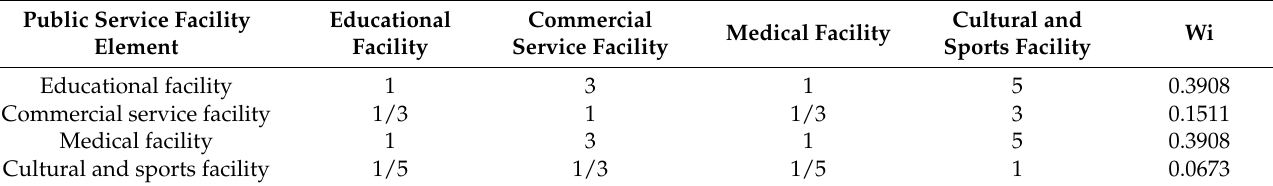
Table 9. Judgment matrix of public service facility element.